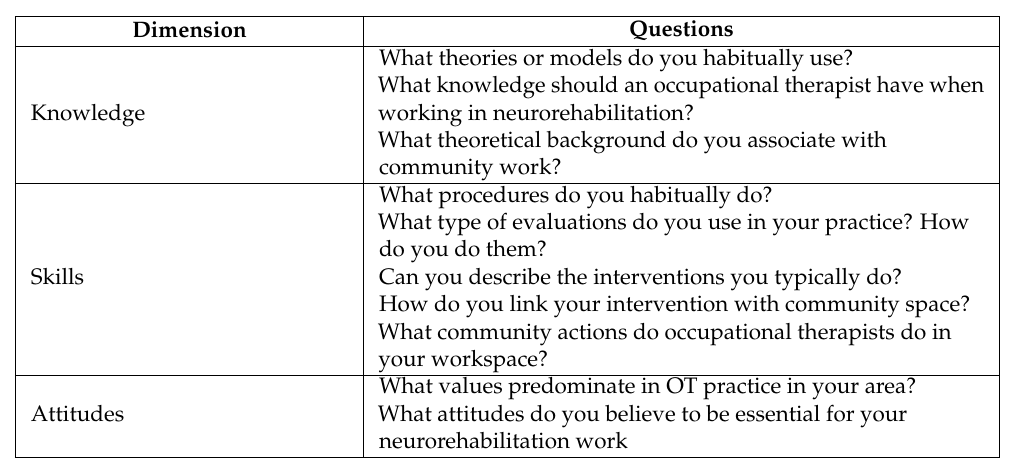
Table 2. Semi-structured interview